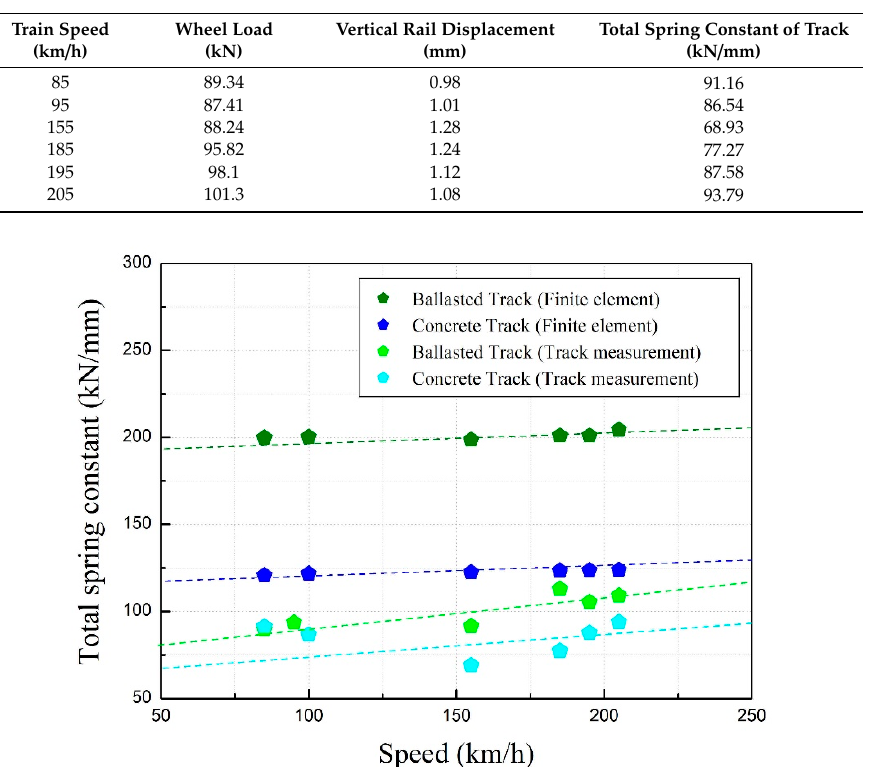
Figure 10. Total spring constant comparison.